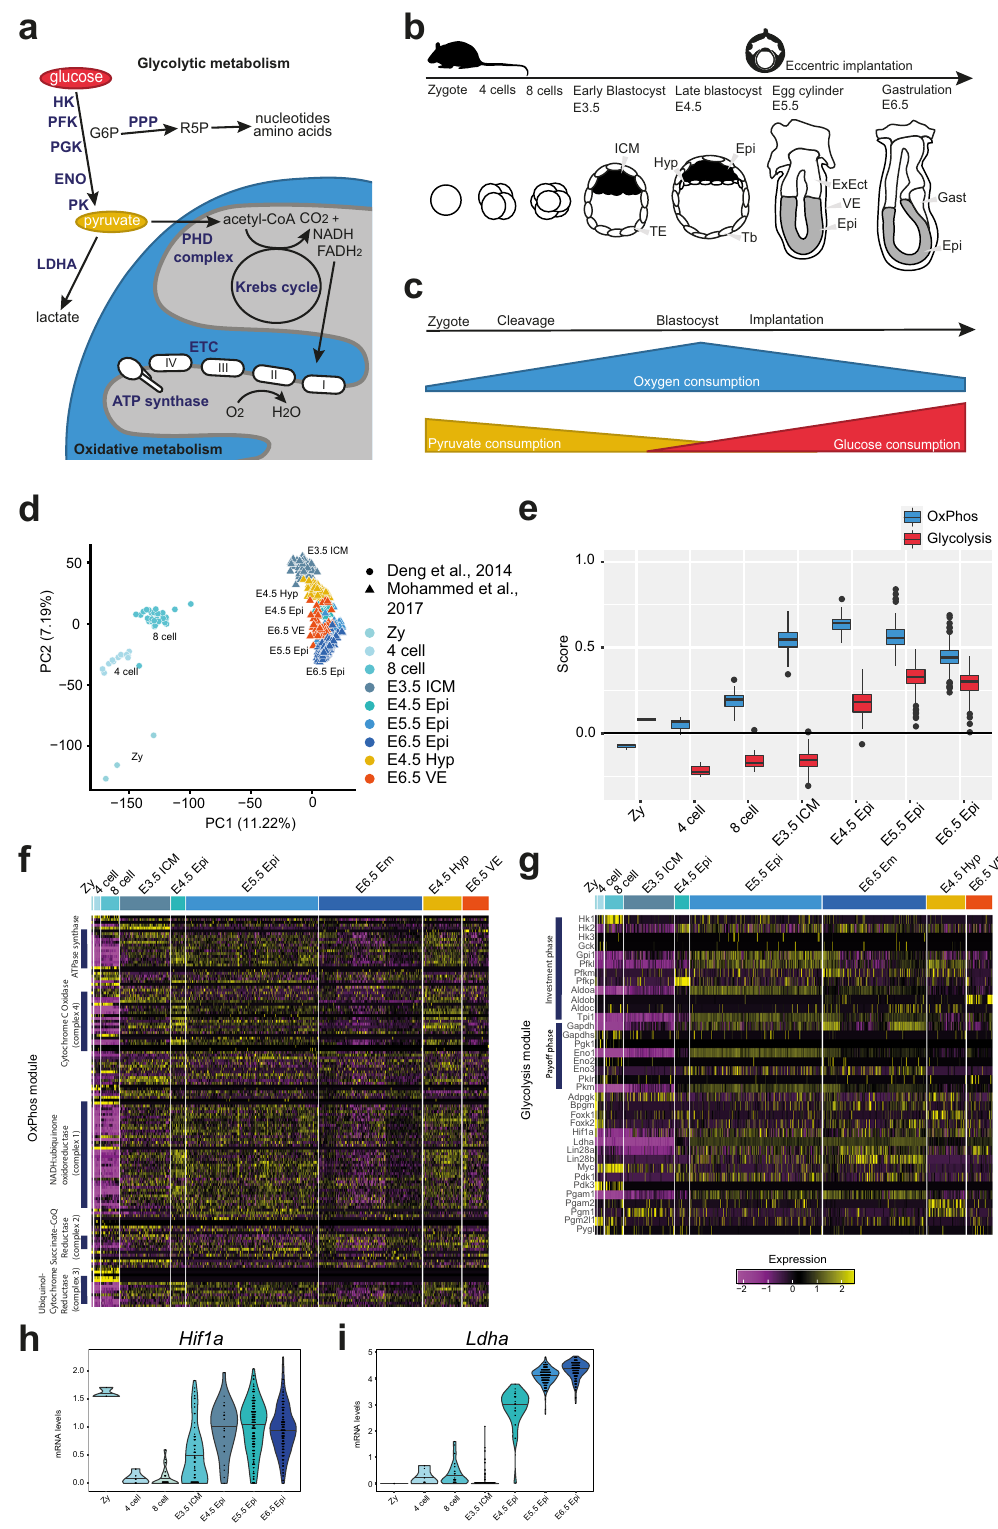
processes of glycolysis and oxidative phosphorylation (OxPhos) (Fig. 1a). Glycolysis converts the 6-carbon molecule glucose dinated large-scale construction of biomass. Similar to (sugar) into two 3-carbon molecules of pyruvate to generate 2 most cellular functions, the anabolic synthesis of biomo- ATPs. In anaerobic conditions, pyruvate is predominantly lecules is thermodynamically unfavourable and thus coupled to reduced to lactate; however, in the presence of oxygen, pyruvate adenosine triphosphate (ATP) hydrolysis as a source of free can be additionally further converted to water and CO 2 by energy 1,2 . In mammalian cells, ATP production relies on the